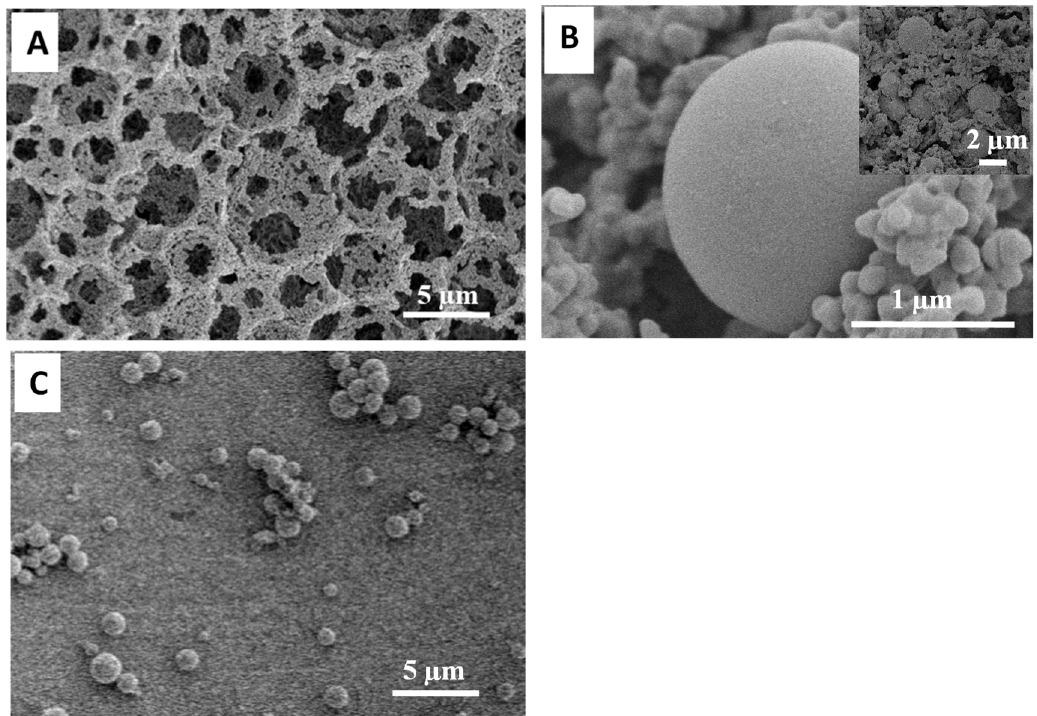
Figure 6. The PAM monolith with smaller macropore voids (prepared from 75 v / v % internal phase emulsion formed by homogenisation) was used for the composite synthesis. ( A ) SEM image of the PAM monolith with smaller pores; ( B ) SEM image showing silica microspheres in the composite monolith; ( C ) the silica microspheres obtained after calcination.